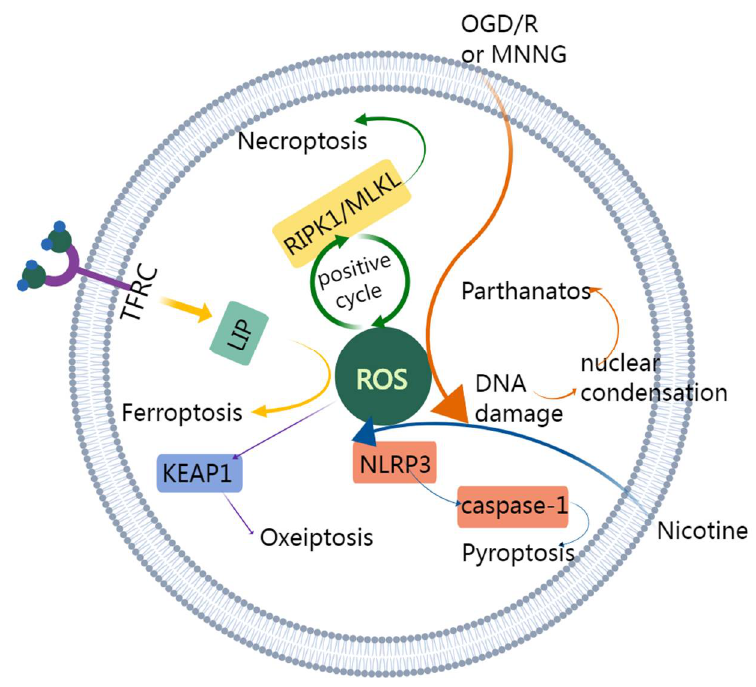
Figure 5. Schematic diagram of ROS in parthanatos, ferroptosis, necroptosis, pyroptosis, and ox- eiptosis.